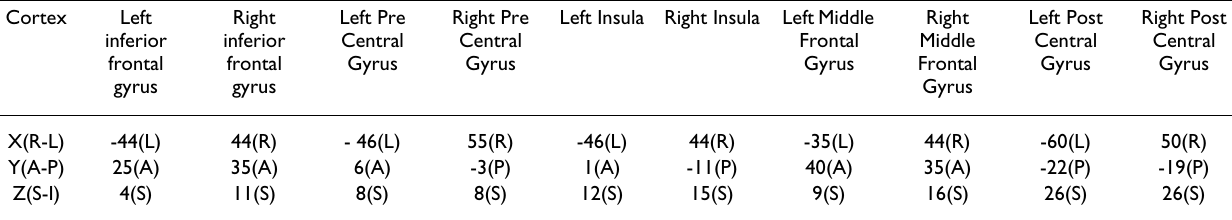
Table 1: Talaraich coordinates of regions activated by true acupuncture